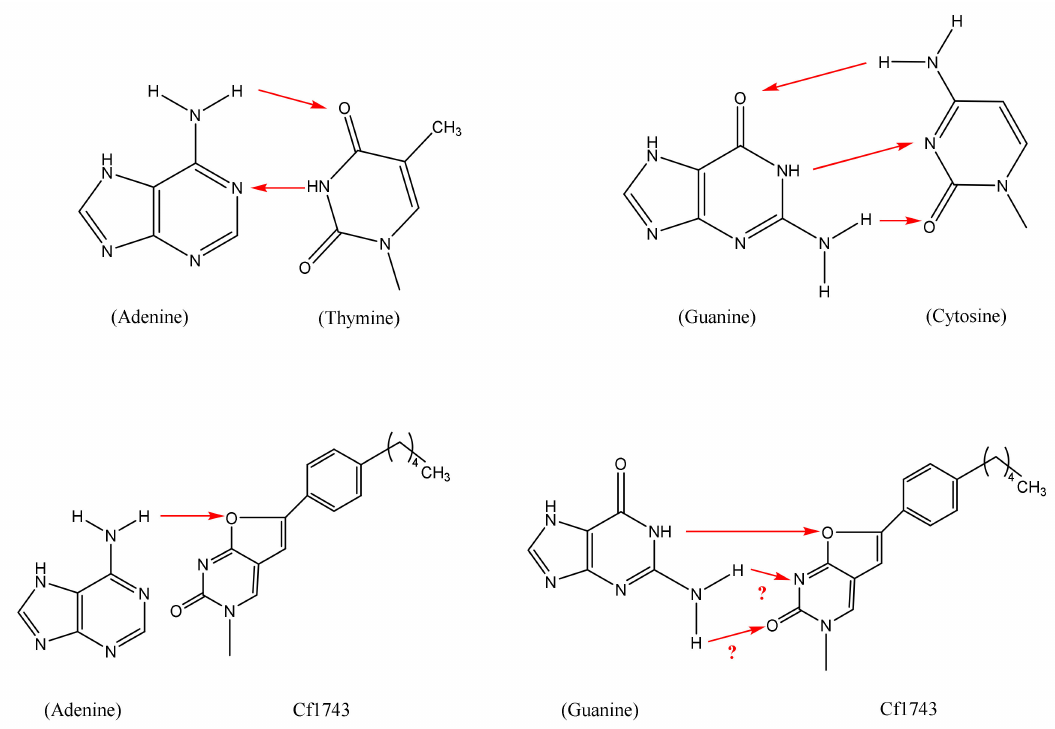
Figure 4. Hypothesis: Watson–Crick type of base pairing (based on formation of two hydrogen bonds) not possible between adenine and Cf1743, but possible between guanine and Cf1743.